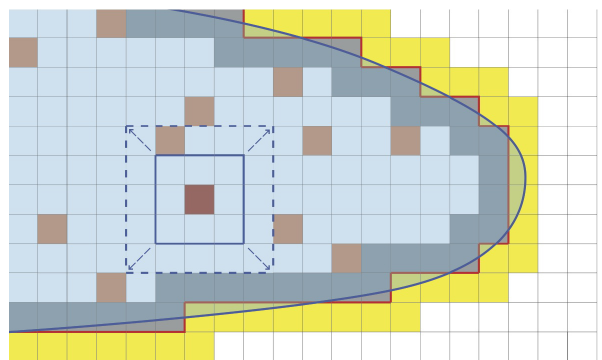
Figure 3. Schematic illustration of GlabTop2: glacier polygons (blue curved line) are converted to a raster matching the DEM cells (red outline). Cells are discriminated as inner glacier cells (light blue), glacier marginal cells (powder-blue), glacier adjacent cells (yellow), and non-glacier cells (white). Auburn cells represent ran- domly selected cells ( r ) for which local ice thickness is calculated; the blue square symbolizes the buffer of variable size, which is en- larged (dashed blue square), until an elevation extent of h min is reached within the buffer (see Appendix for full details and an in- depth discussion of the